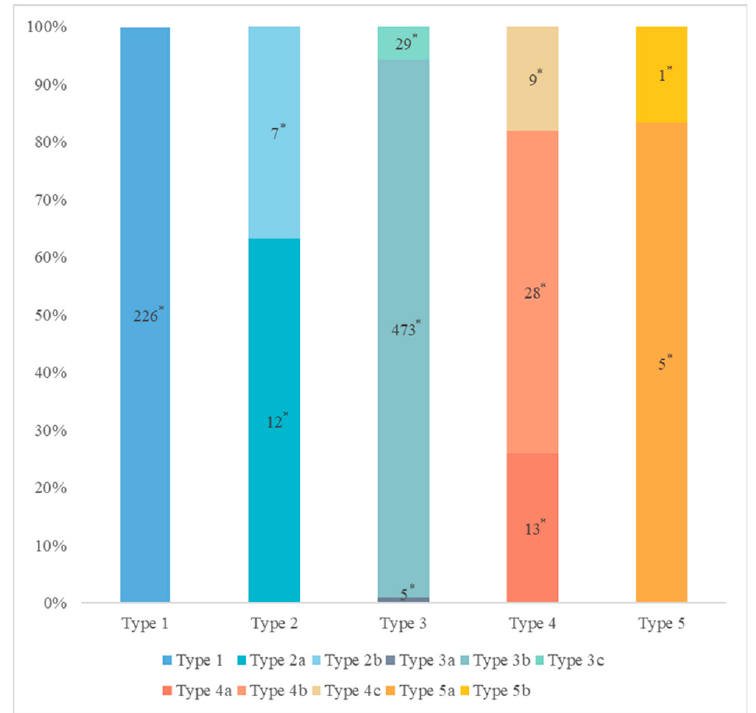
Figure 3. The distribution of pancreatic duct variation. * Quantity of subjects. The MPD flowed into the MP, and no APD was the most common anatomical type (type 3b, Figure 4) (58.5%, 473/808); the second type was a classical double division with the double duct structure (type 1, Figure 5) (28.0%, 226/808).